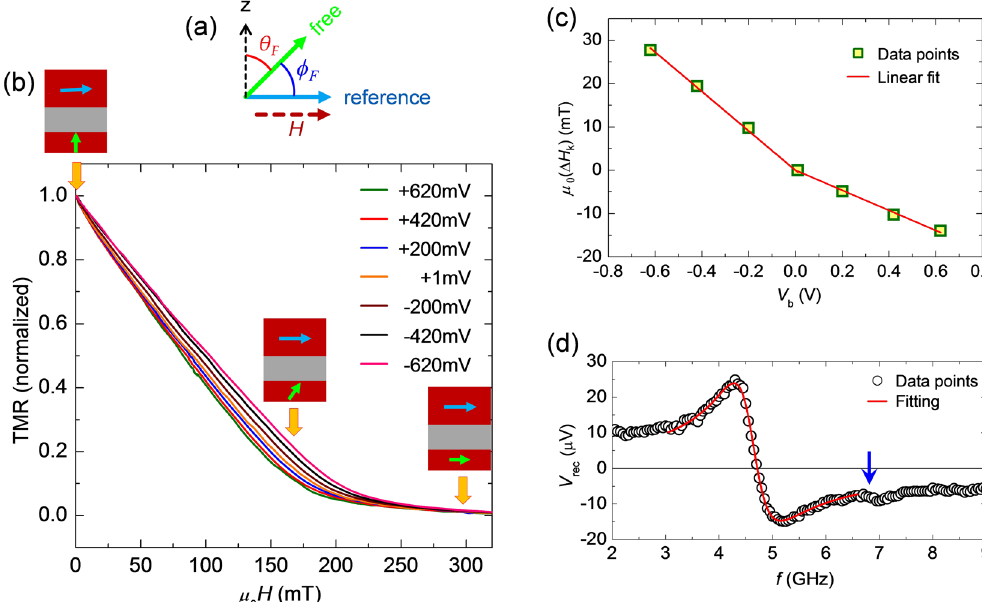
Figure 2. PMA versus voltage and typical rectified voltage signal in linear regime. ( a ) Schematic diagram for the geometry of free & reference layer magnetizations and bias magnetic field. ( b ) Normalized TMR as a function of µ 0 H for different values of V b . The schematic diagrams show the alignment of magnetizations for free and reference layers. ( c ) Variation of change in µ 0 H k with V b . Solid lines correspond to the linear fitting to find out the slope. ( d ) Typical plot of V rec as a function of f measured at P rf = 5 µ W. Solid line represents the fitted curve with Eq.